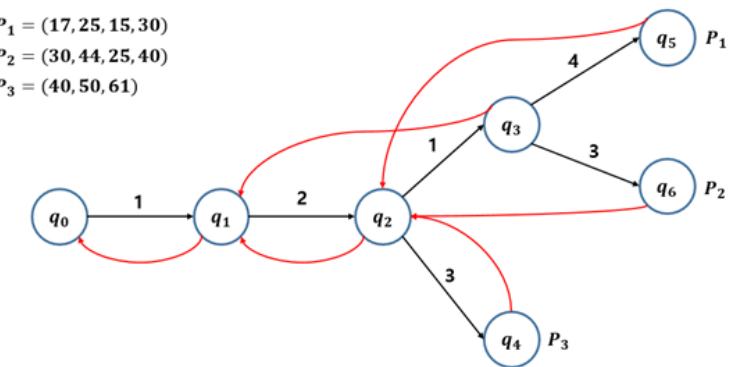
Figure 1. Example of the Aho–Corasick automaton for OPMPM.